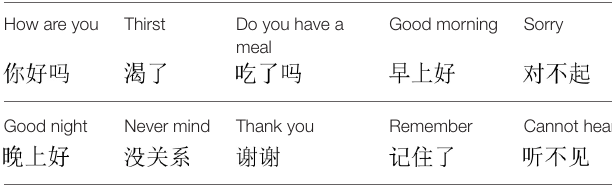
TABLE 1 | The Chinese words and their translations used for spelling experiment.